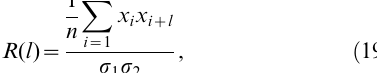
data sets given the perfect convergence of the synthetic distributions towards the model distribution for increasing n . Table S1 Comparison of the single-parameter power law with the lognormal and the gamma distribution using the LLR test for decorrelated